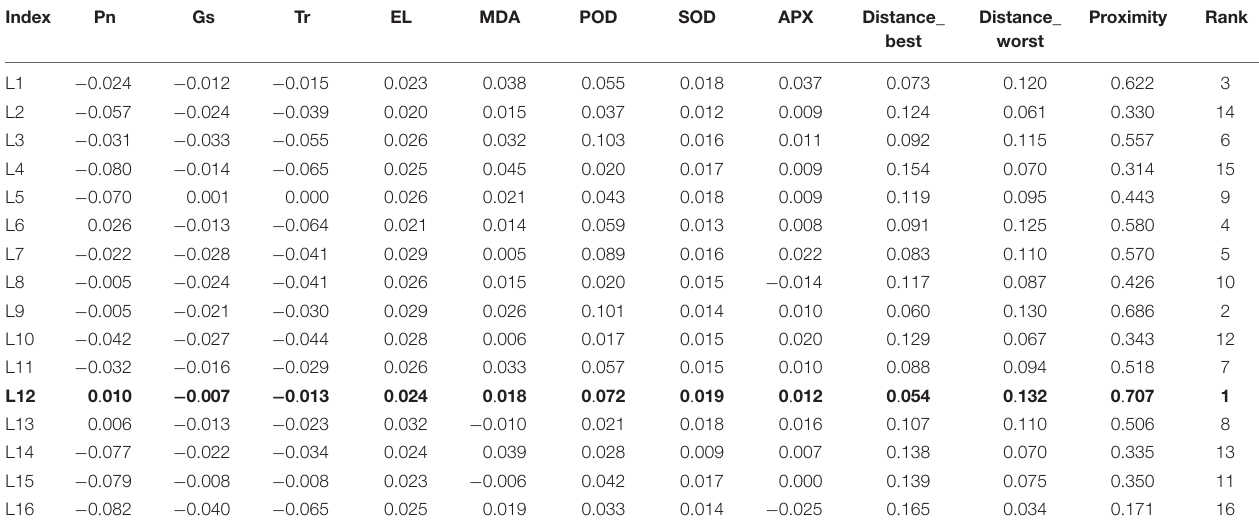
TABLE 2 | Analysis of weight evaluation and rank for the physical index of cold resistance in the bermudagrass collected from 16